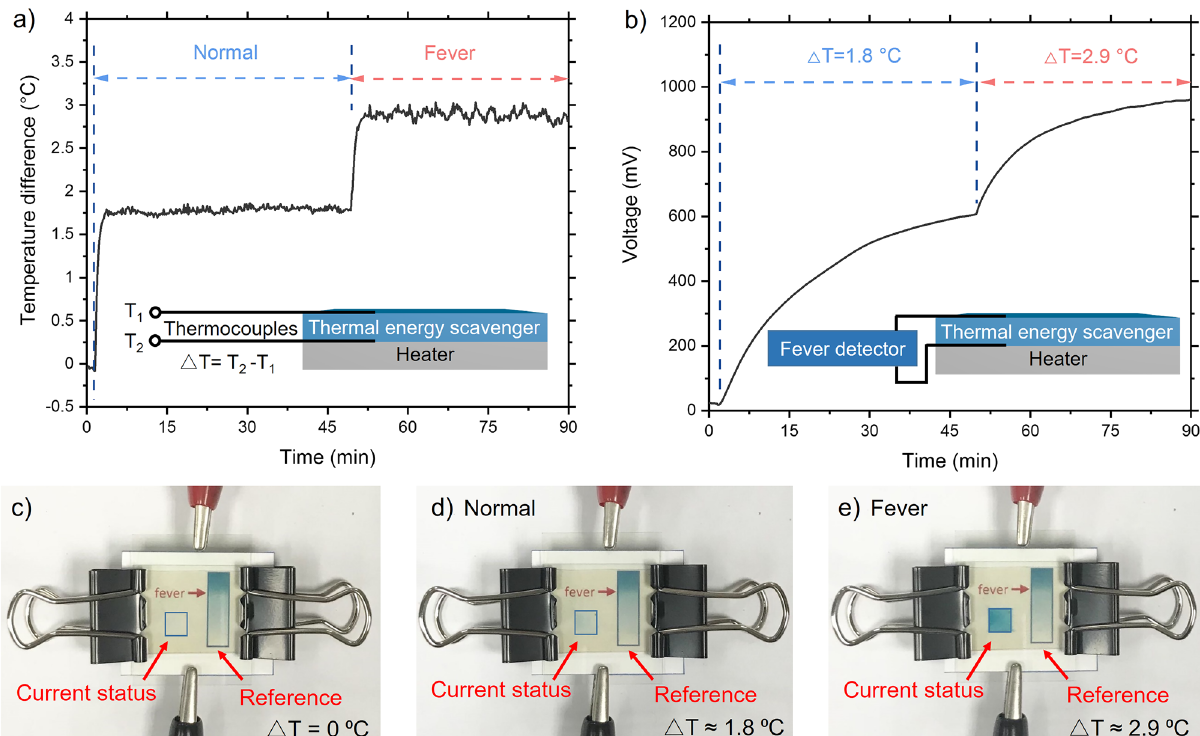
Fig. 5 Operation of an electrochromic fever detector by a thermo-hydro-electrochemical energy harvester. a Temperature difference as a function of time when heat is dissipated at the rates of 360 W m − 2 and 580 W m − 2 , to mimic normal and fever conditions, respectively. The inset illustrates the temperature-measurement con fi guration with a heater. b Voltage pro fi le as a function of time from serially connected four devices under the temperature differences of 1.8 and 2.9 °C. The inset illustrates that the thermal energy harvester was directly connected to the fever detector. c A photograph of the fever detector with an electrochromic display window showing the current status and a reference color bar when heat is not supplied to the device ( △ T = 0 °C). d When △ T ≈ 1.8 °C, the color in the status window became light blue, indicating the device was working under a normal condition. e When △ T ≈ 2.9 °C, the status window displayed dark blue above the fever color in the reference